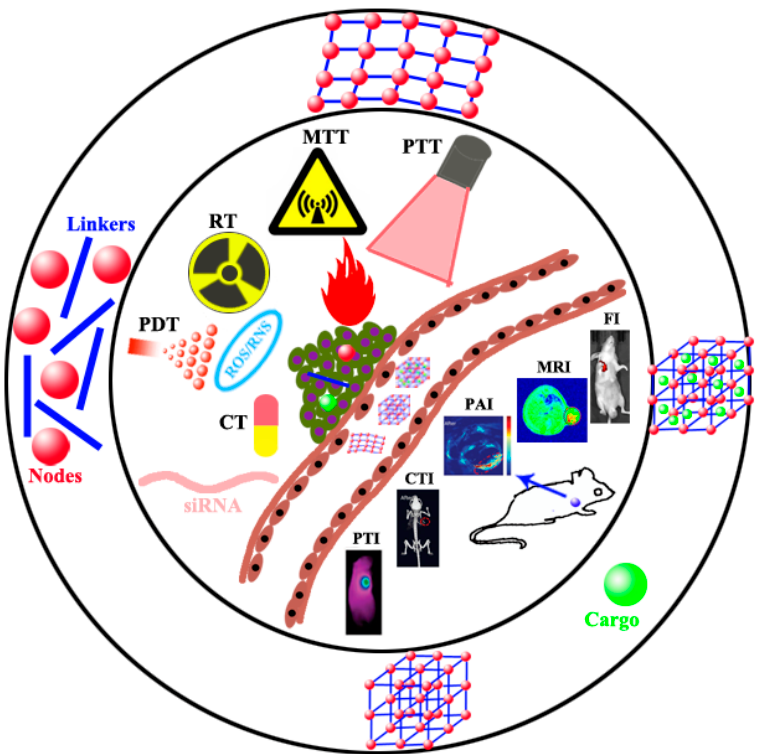
Figure 1. Schematic diagram of MOFs as nano-drugs and nanocarriers for multimodal theranostic, typically comprising a suitable and effective combination of CT, CDT, RT, RDT, PTT, PDT, MDT, MTT, gas therapy and gene therapy, and imaging of FI, MRI, PAI, CTI and PTI.